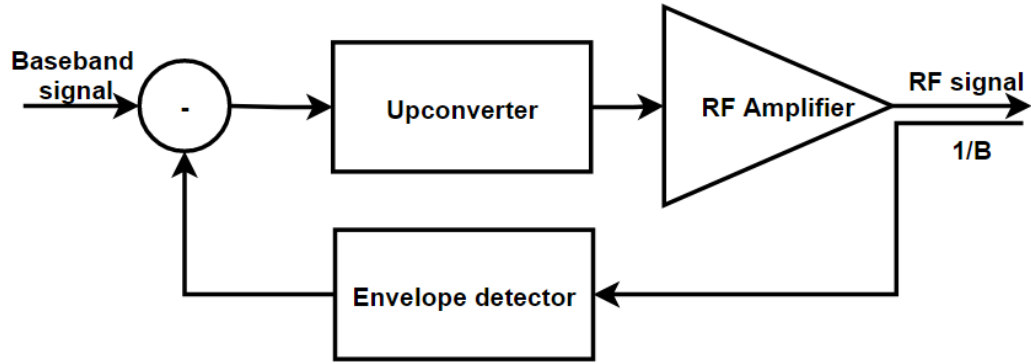
Figure 5. Envelope feedback operational diagram.